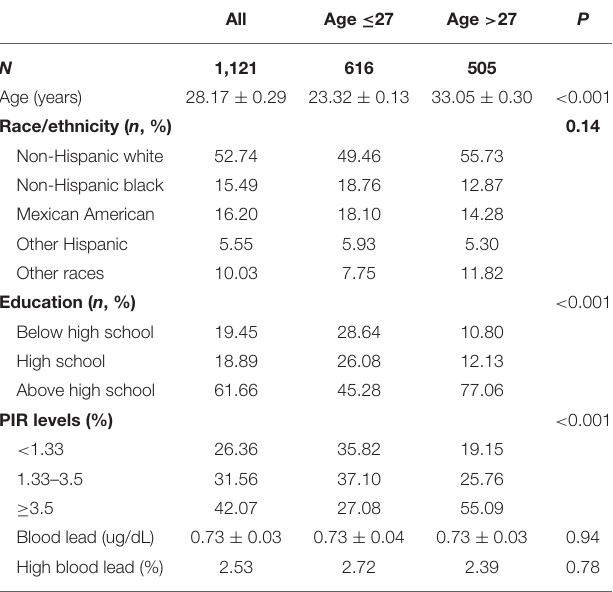
TABLE 1 | The characteristics of participants. TABLE 2 | The weighted logistic regression on the prevalence of high blood lead in pregnant